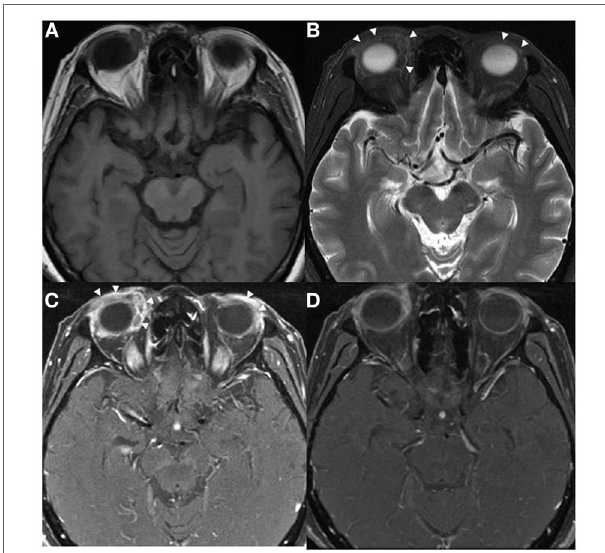
FIGURe 1 | Axial MRI of patient 1 showed predominately extraconal infiltrating soft tissue lesions in both orbits (arrowheads) with significant preseptal component, they were hypointense on T1W (a) and T2W (B) images with heterogeneous contrast enhancement (C,D)